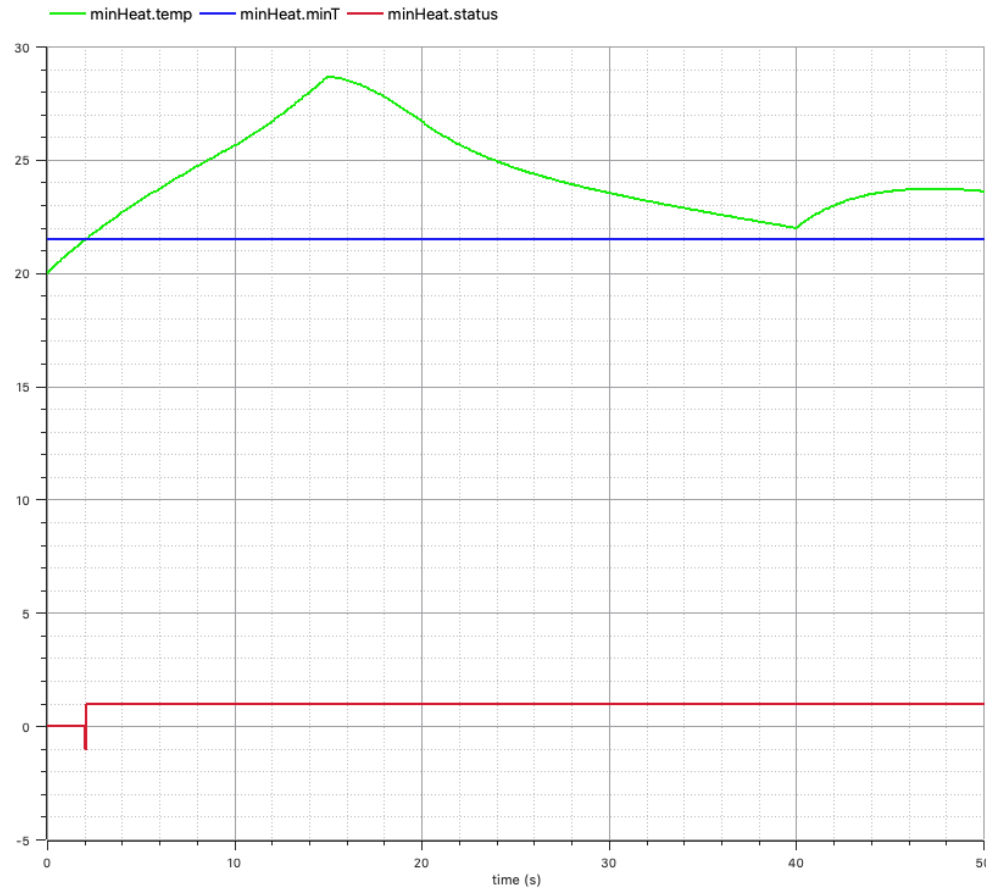
Figure 14. Requirement Req. 003 is violated after the first 2 s because the room is warming up too slowly.